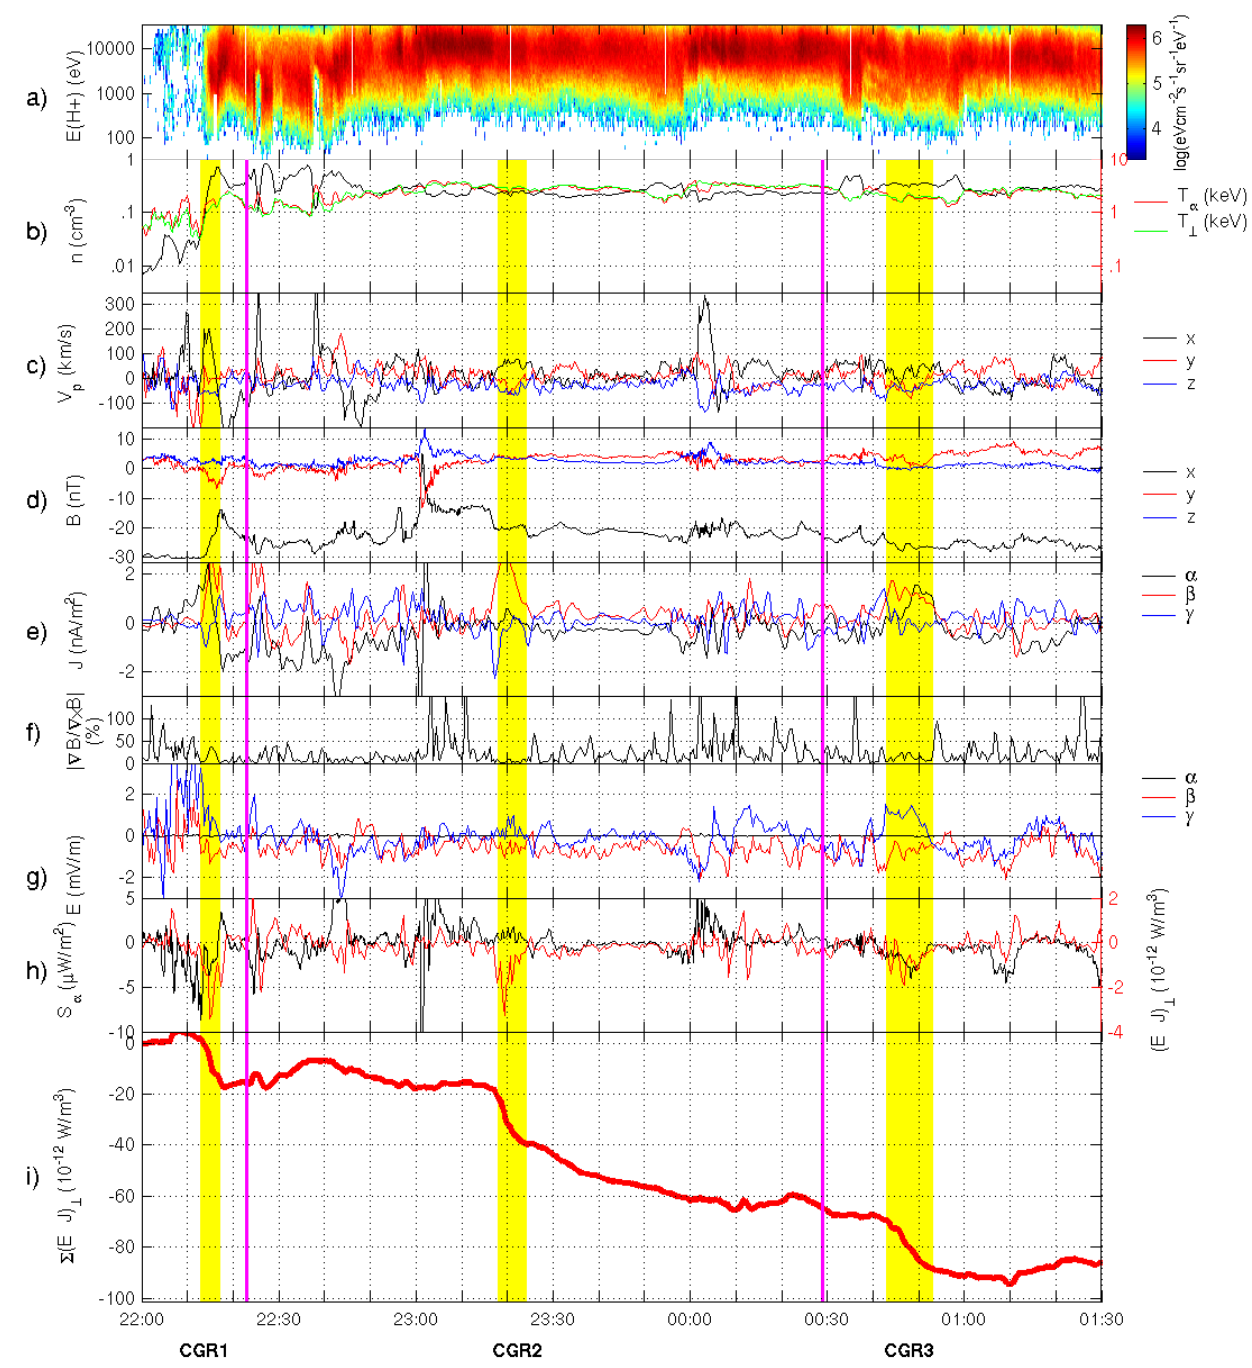
Fig. 3. Cluster data for 19–20 September 2001. All data are smoothed so that variations faster than 24s are removed. (a) CODIF proton energy spectrograms from S/C 1; (b) proton density (black), parallel (red) and perpendicular (magenta) proton temperature from CODIF on S/C 1; (c) CODIF plasma flow velocity in GSE from S/C 1; (d) magnetic field in GSE from the FGM experiment on S/C 1; (e) MAG α , β , and γ components of the curlometer current density; (f) normalized divergence of the magnetic field; (g) CODIF electric field in MAG average over S/C 1, 3, and 4; (h) field-aligned Poynting flux (black) and power density (red) averaged over S/C 1, 3, and 4 (the CODIF electric field is used); (d) cumulative sum of the power density from the previous panel. The concentrated generator regions CGR1–CGR3 (indicated with yellow bands) appear when there are clear dips in the power density in panel (h) and hence sharp gradients in the cumulative sums in panel (i). The conjunctions with the FAST satellite are shown with the vertical magenta